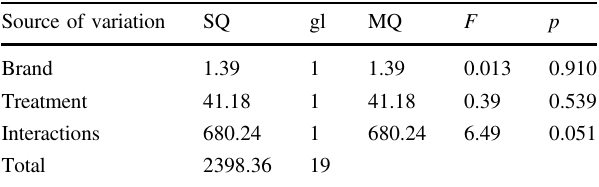
Table 4 Results referring to the ANOVA two-way statistical test for